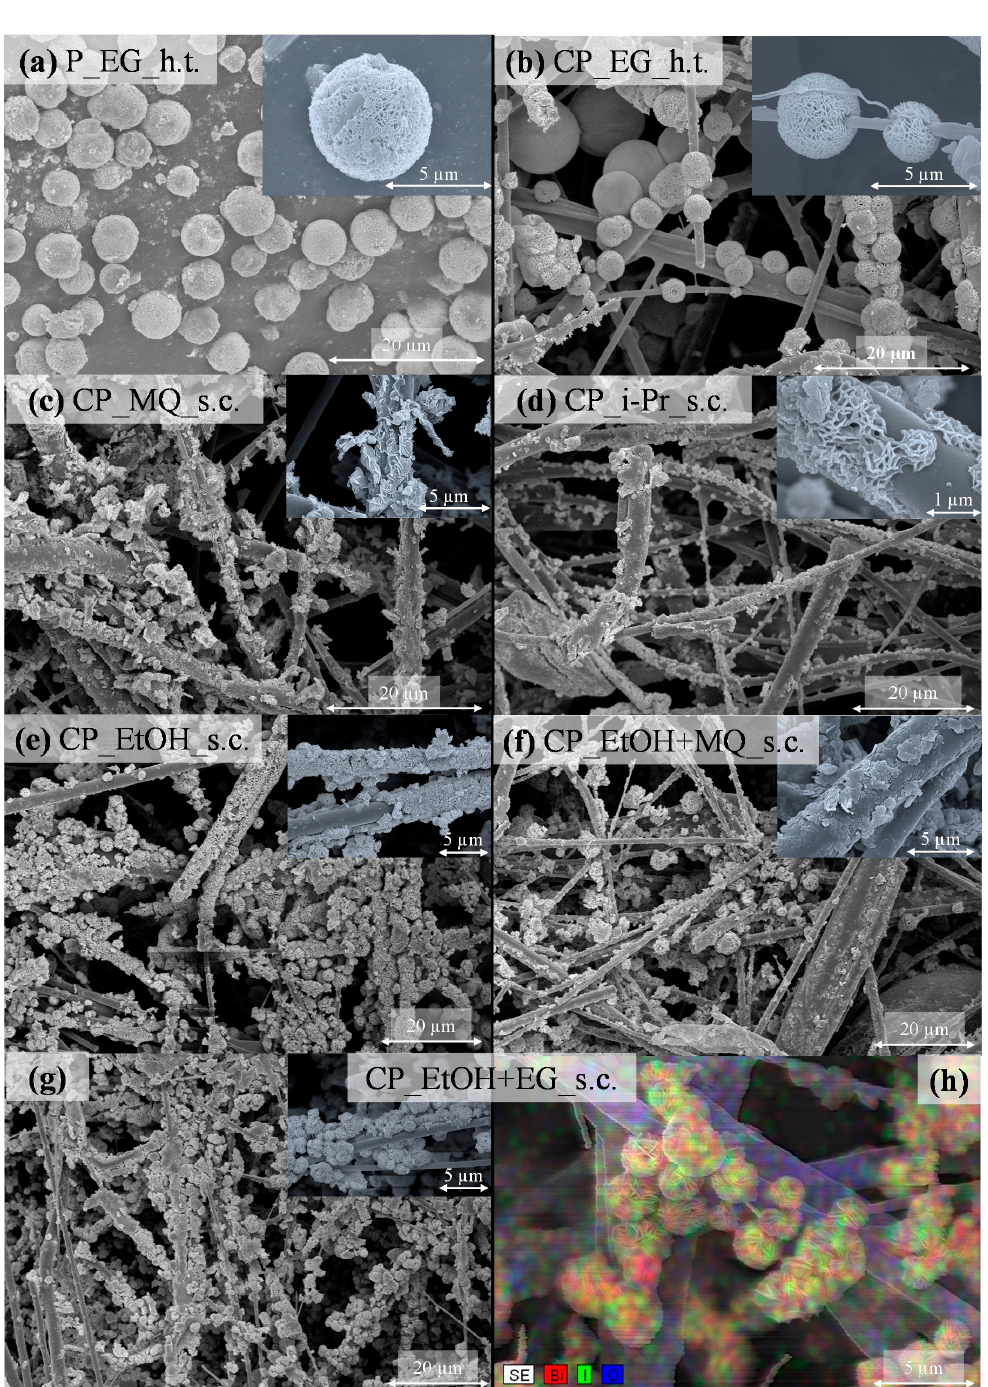
Figure 3. E ff ects of the solvent / matrix on the BiOI morphology, ( a ): well-structured BiOI